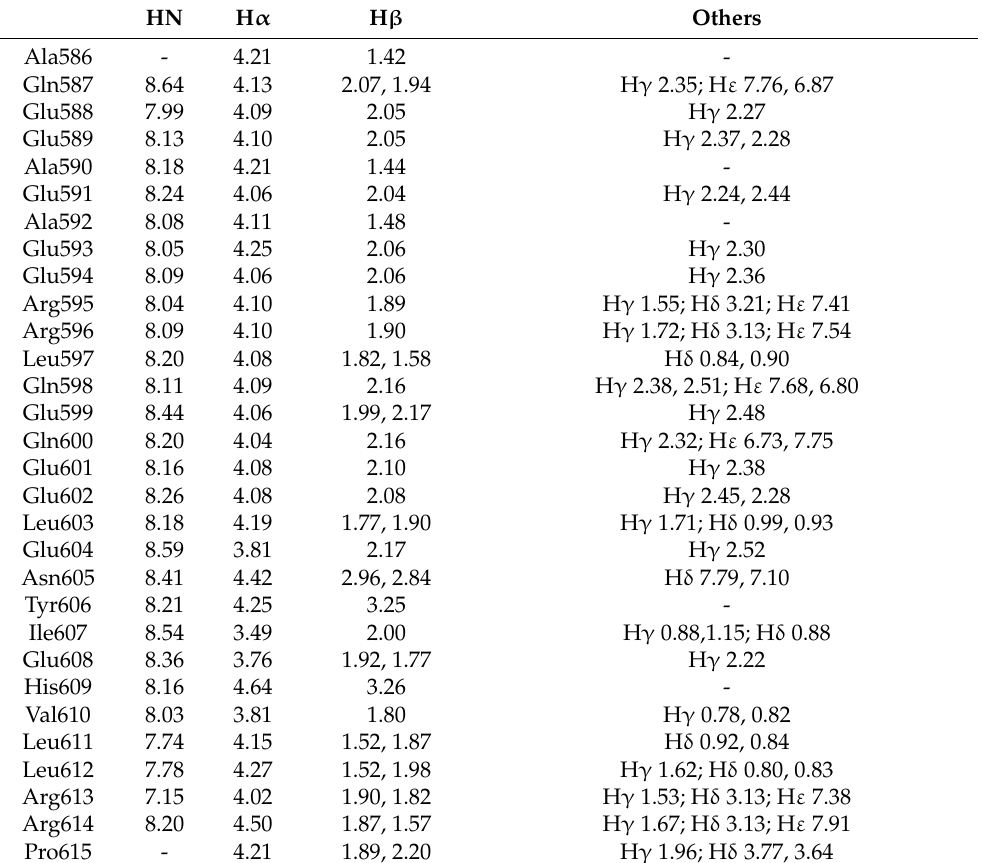
Table 2. AQEE-30 chemical shifts of the assigned 1H resonances in the DPC micelle